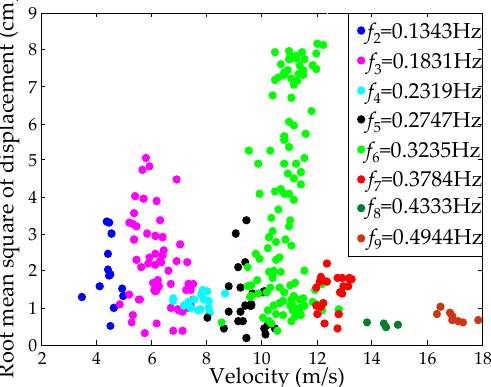
Figure 23. Relationship between 10 min mean wind velocity and root mean squares (RMS) of displacement at quarter span.